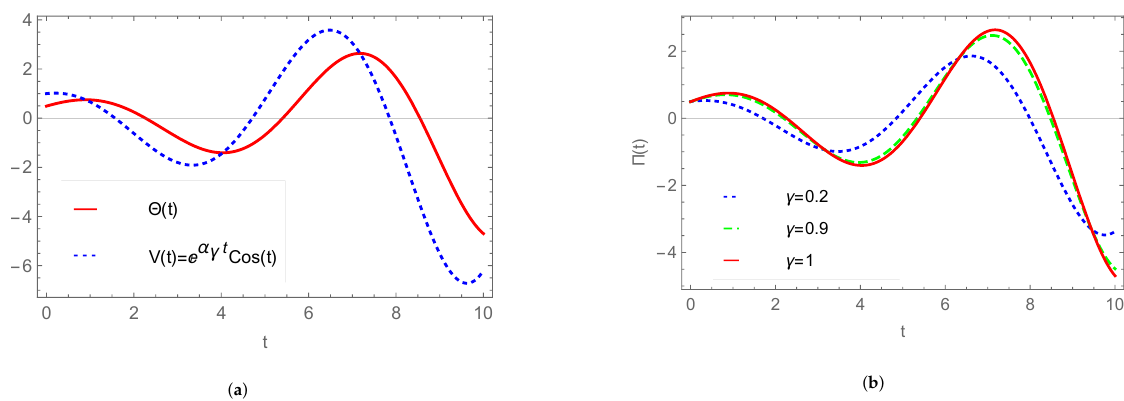
Figure 8. Same comparison as Figure 7 between Θ ( t ) in (56) and f ( t ) in (55), for α γ = 0.2 and σ γ = 1. ( a ) Non-fractional RL circuit; ( b ) Solutions of fractional RL circuit, Θ ( t ) , for different values of γ